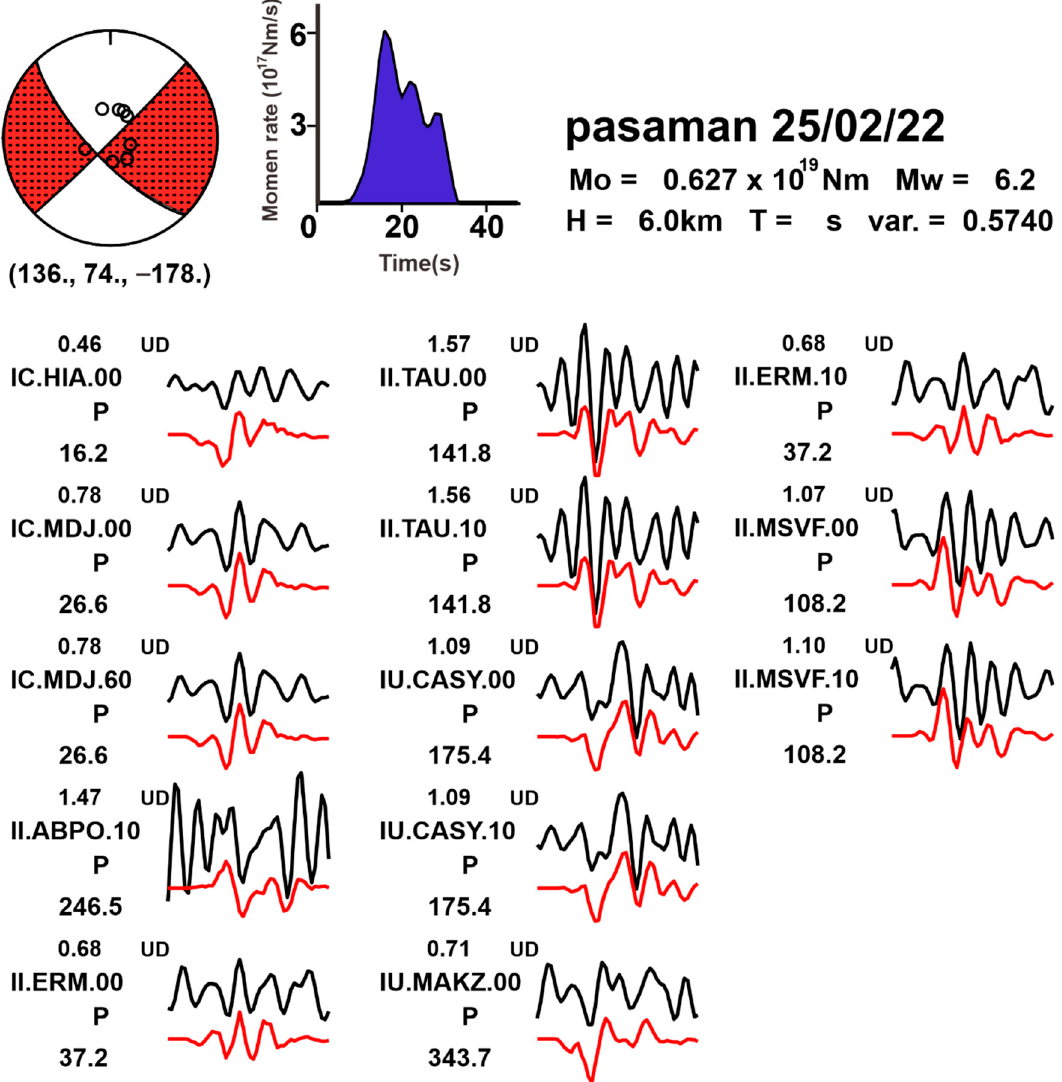
Figure 7. Moment rate function, focal mechanism, and comparison of observation data (black line) and synthesis data (red line) at seismic stations used in the Pasaman earthquake inversion analysis. The small ball on focal mechanism shows the number of recorded seismic stations, red for the compression zone and white for the dilation zone.